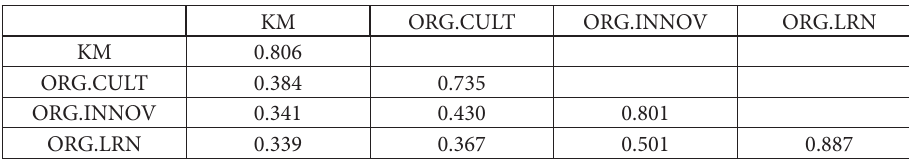
Table 5. Latent variable correlation – Discriminant validity assessment using Fornell’s and Larcker’s (1981)